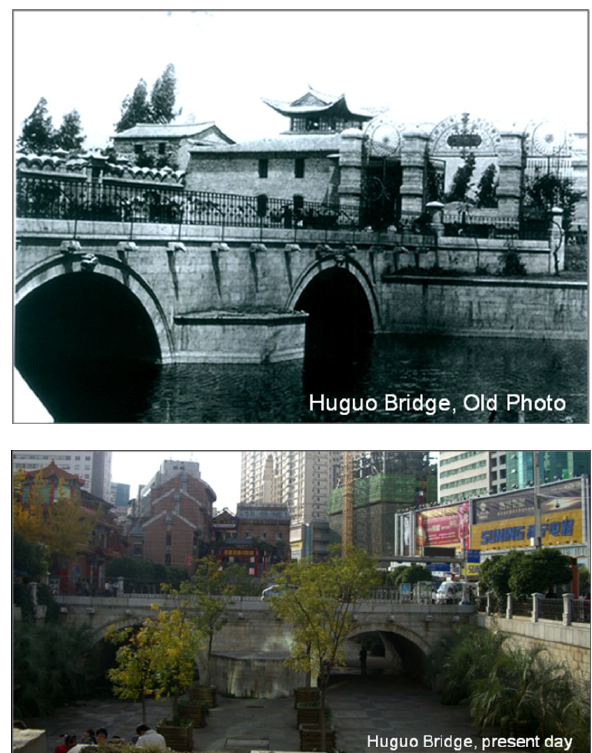
Figure 5. Historic and Contemporary Photos of